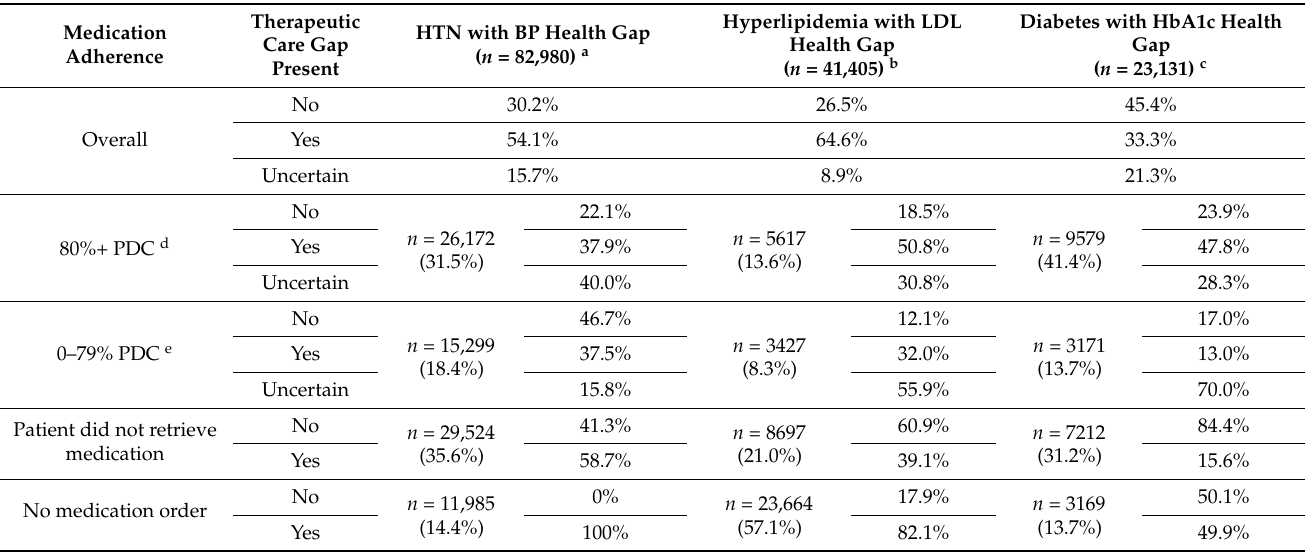
Table 4. Prospective therapeutic care gap (no actions taken to close health gap) status among primary care patients 35+ years old diagnosed with hypertension, hyperlipidemia, or diabetes who have a disease specific health gap by medication adherence